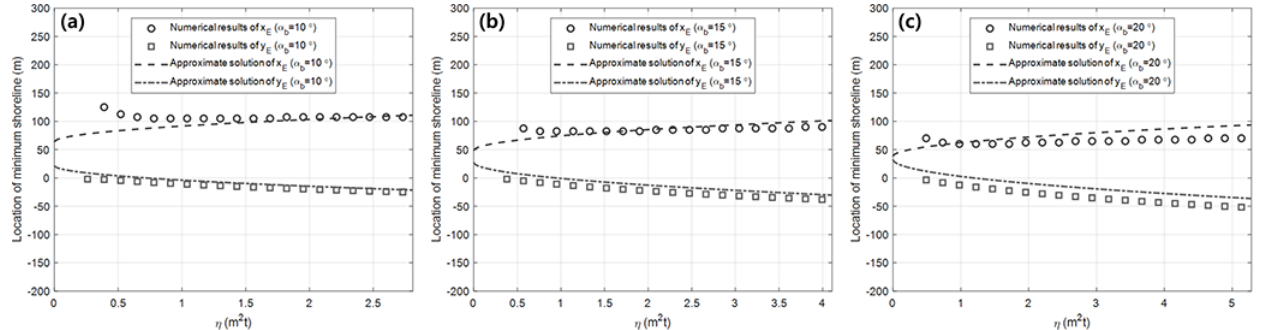
Figure 15. Comparison between analytical and numerical results for breaking wave direction α b of (a) 10 ◦ , (b) 15 ◦ and (c) 20 ◦ for Jeong- dongjin Beach. Table 1. Comparison between the control point locations obtained from NOAA wave data and from Eq. (22). α b